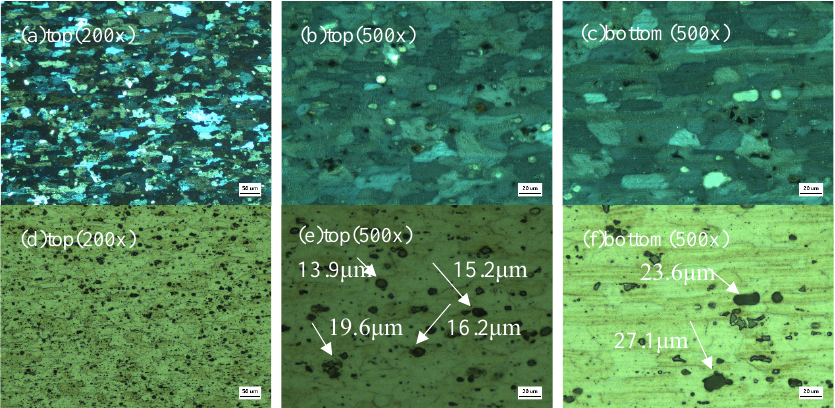
Figure 13. Metallograph of flame straightening: ( a – c ) under polarized light; ( d – f ) bright field.